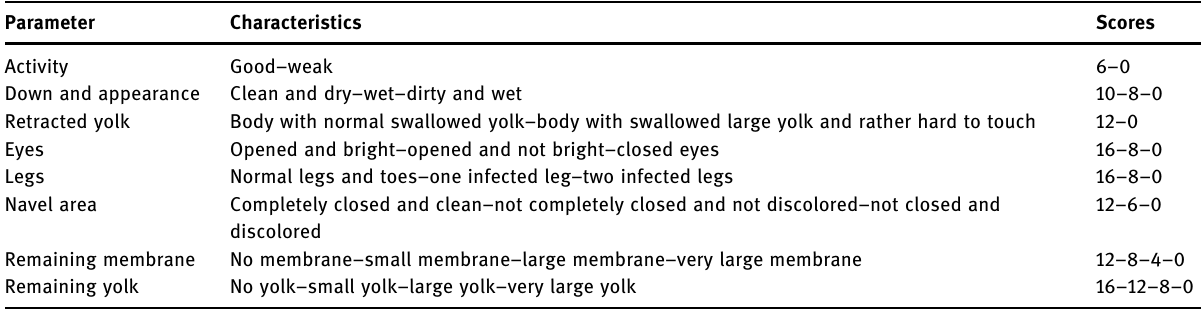
Table 2: Parameter for determining chick quality in the Tona score method Parameter